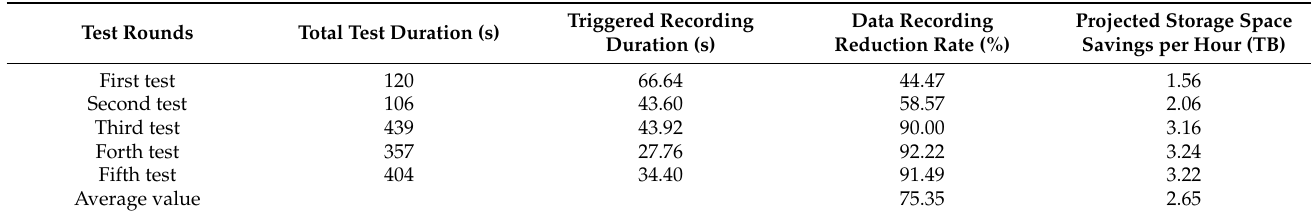
Table 1. Quantitative analysis